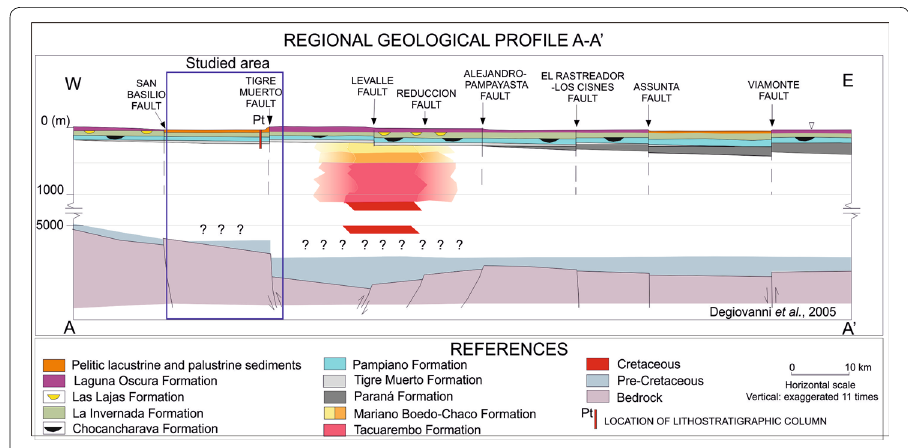
Fig. 3 Regional geological profile (Degiovanni et al.